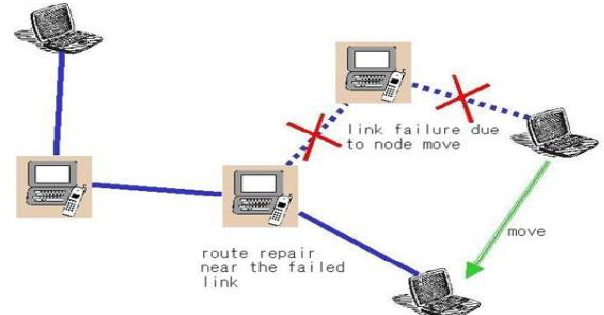
Figure 1. Architecture of Mobile ad-hoc